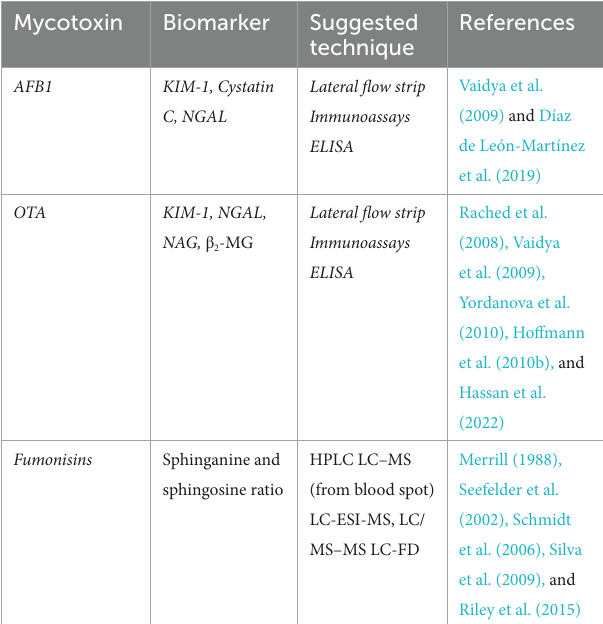
TABLE 1 A brief summary of the suggested techniques, what biomarkers might be used for detection of mycotoxin induced nephrotoxicity.